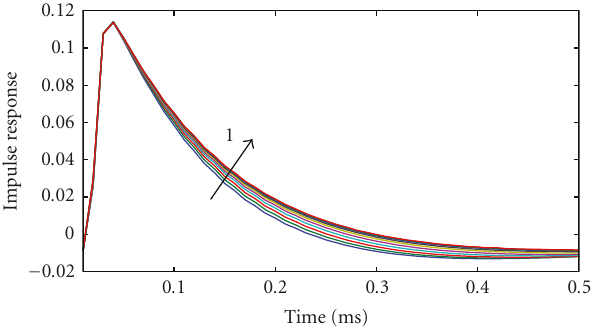
Figure 13: Impulse responses a 1, l ( t ) of the first branch of the nonlinear model ( N = 7) depicted for di ff erent input levels (pedal